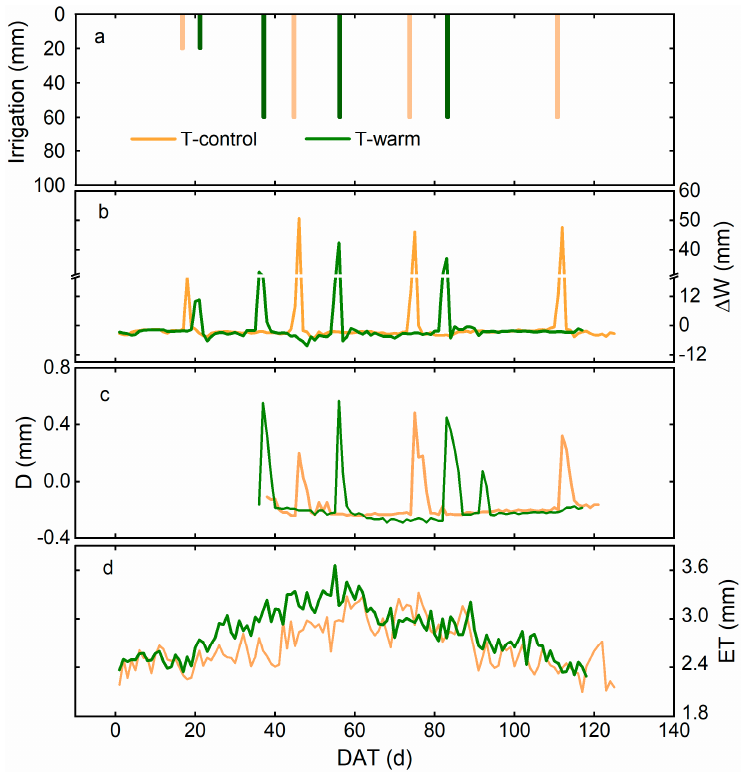
Figure 5 Daily variations in ( a ) irrigation, ( b ) Δ W, ( c ) D and ( d ) ET during the growing season of Figure 5. Daily variations in ( a ) irrigation, ( b ) ∆ W, ( c ) D and ( d ) ET during the growing season of maize maize under T-control and T-warm experiments. Δ W represents soil water storage change. D under T-control and T-warm experiments. ∆ W represents soil water storage change. D represents represents drainage at the bottom of the lysimeter. ET indicates crop evapotranspiration. drainage at the bottom of the lysimeter. ET indicates crop